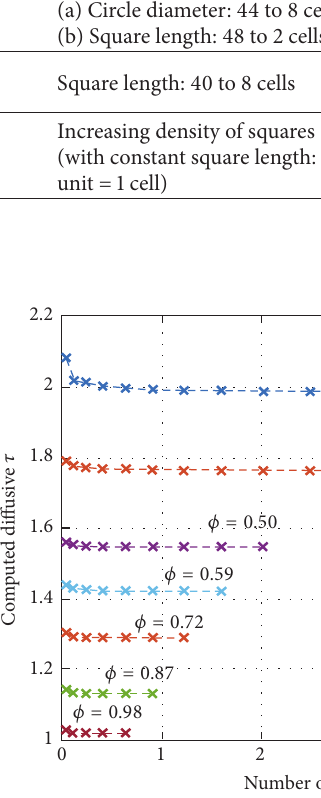
Figure 3: Fluid flow past a solid circle, 𝜙 = 0.71 , driven by 𝑔 𝑥 . Non- dimensional fluid speed (i.e., magnitude of velocities) is indicated by color, and flow path is indicated by flow lines (direction is left to right). Speed profile and flow path driven by 𝑔 𝑦 are same as shown but rotated 90 degrees.